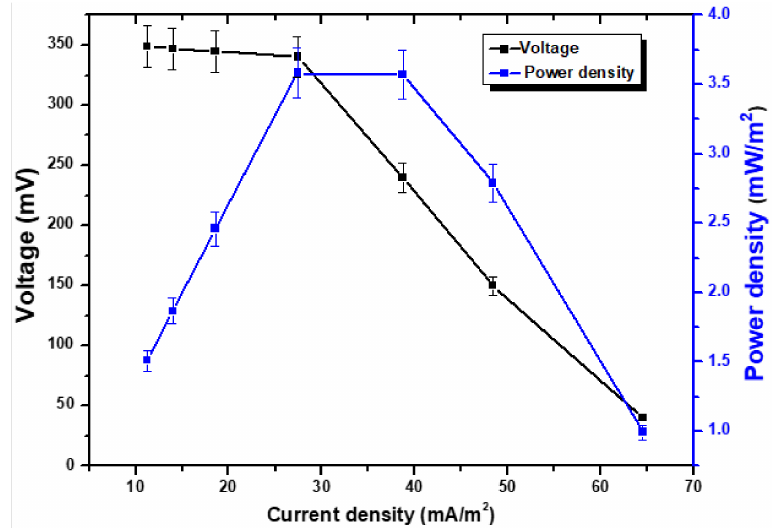
Figure 3. Polarization trend of the present study with organic feeding. The CV study was recorded during the procedure at several periods. The graphs demonstrate the metals’ tendency for redox reaction across a range of period scales. Figure 4 illustrates how the BMFC operation showed the maximum current for both scan (forward and reverse) speeds. The greatest current, measured by the forward scan, was 6 × 10 − 6 mA on cycle day 70. Similar to this, the reverse scan current was − 4.2 × 10 − 4 mA on cycle day 70. The forward and backward scans on day 70 indicated that the current was at its maximum value. Forward and reverse scans show the rates at which metal ions in wastewater are oxidized with reduction. On day 70, the redox peak was maximum at 0.8V oxidation, while reduction peak